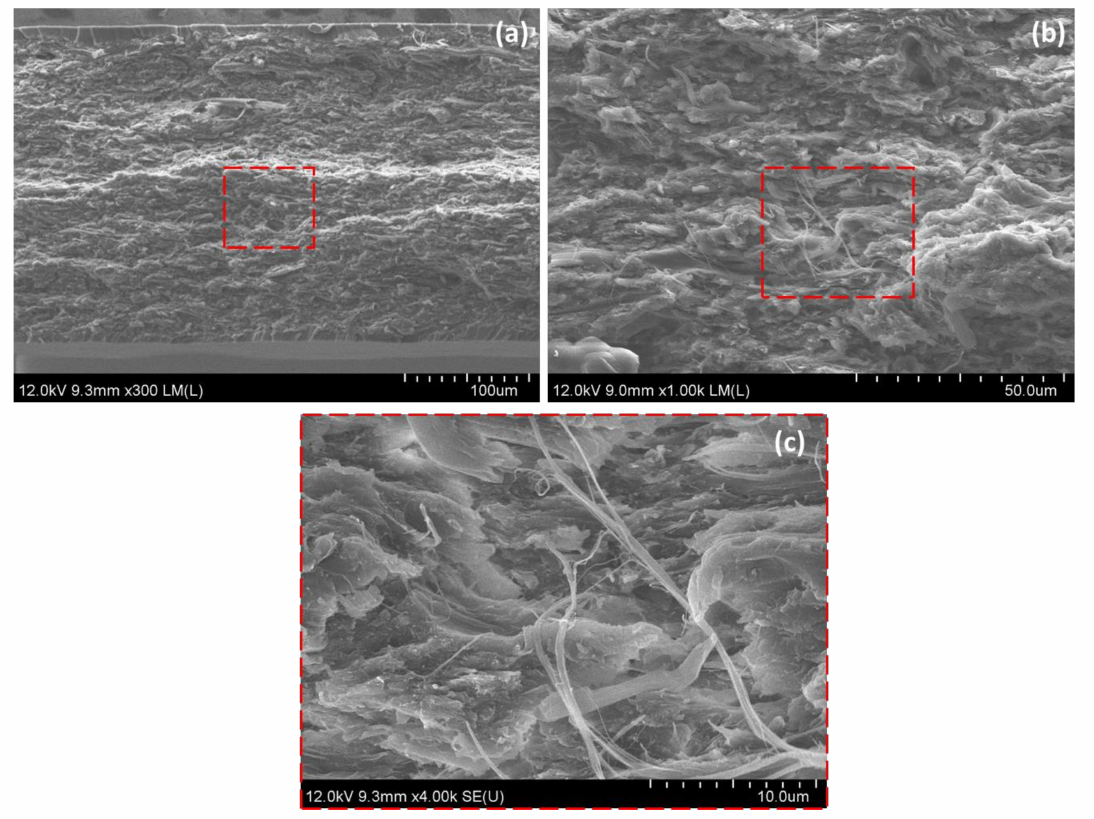
Figure 9. FESEM images. ( a ) Fracture surfaces of 1 wt % solvent treated CNF epoxy composites and ( b , c ) high magnifications of 1 wt % solvent treated CNF epoxy